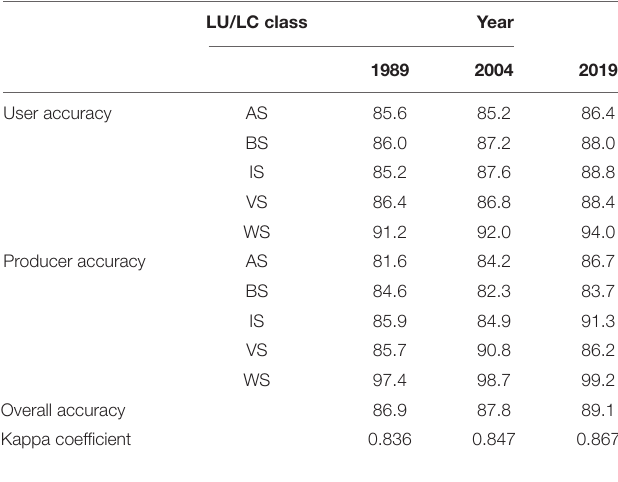
TABLE 2 | Accuracy assessment report for LU/LC classification (1989–2019) for Bengaluru